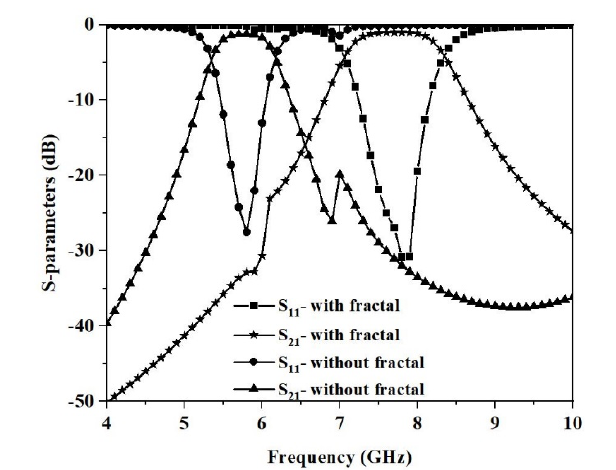
FIGURE. 12. S-PARAMETERS OF SYMMETRICAL RING RESONATOR BANDPASS FILTERS WITHOUT AND WITH MOORE